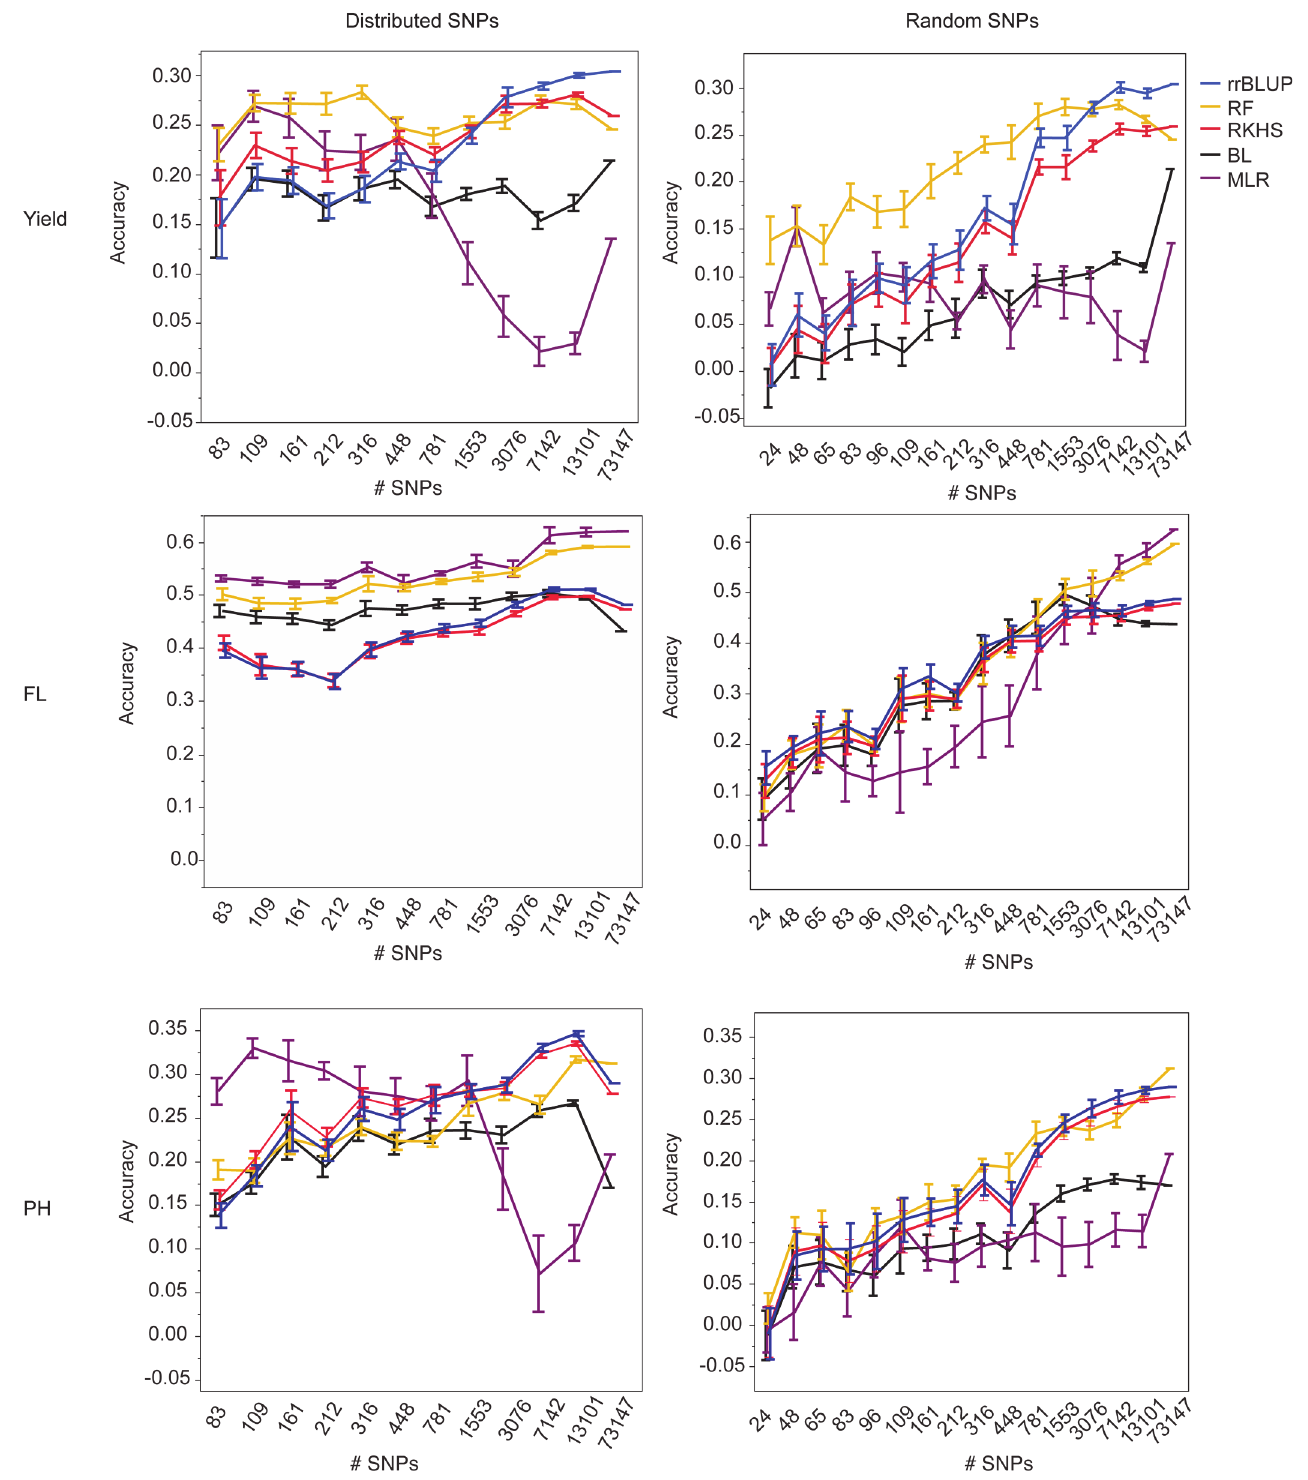
Fig 1. Mean accuracies of cross-validation for prediction of grain yield (Kg/ha) (top row), flowering time (days to 50% flowering) (middle row), and plant height (cm) (bottom row) in the 2012 dry season, using 10 selections of SNP subsets either distributed evenly throughout the genome (right column) or chosen at random (left column) and five different statistical methods, error bars constructed using 1 standard error from the mean. The training population consisted of data from years 2009 – 2011, both seasons per year.